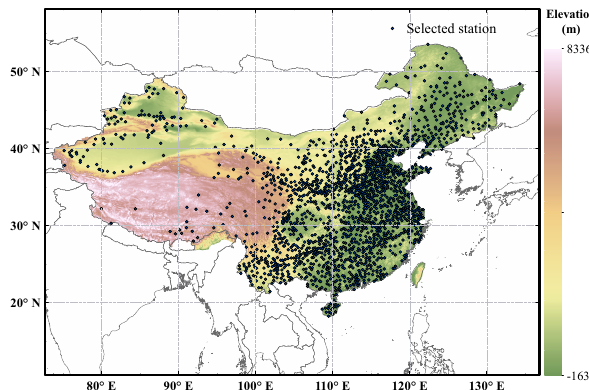
Figure 1. Elevation map of mainland China and spatial distribu- tion of the 1977 meteorological stations used in this study. The datasets were provided by China’s National Meteorological Infor- mation Center (You et al., 2016) (http://data.cma.cn/data/cdcdetail/